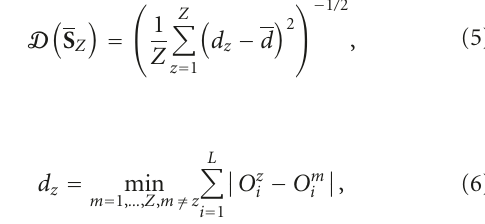
Table 1: Two di ff erent sets of solutions S a and Z = 4. They are displayed in Figure